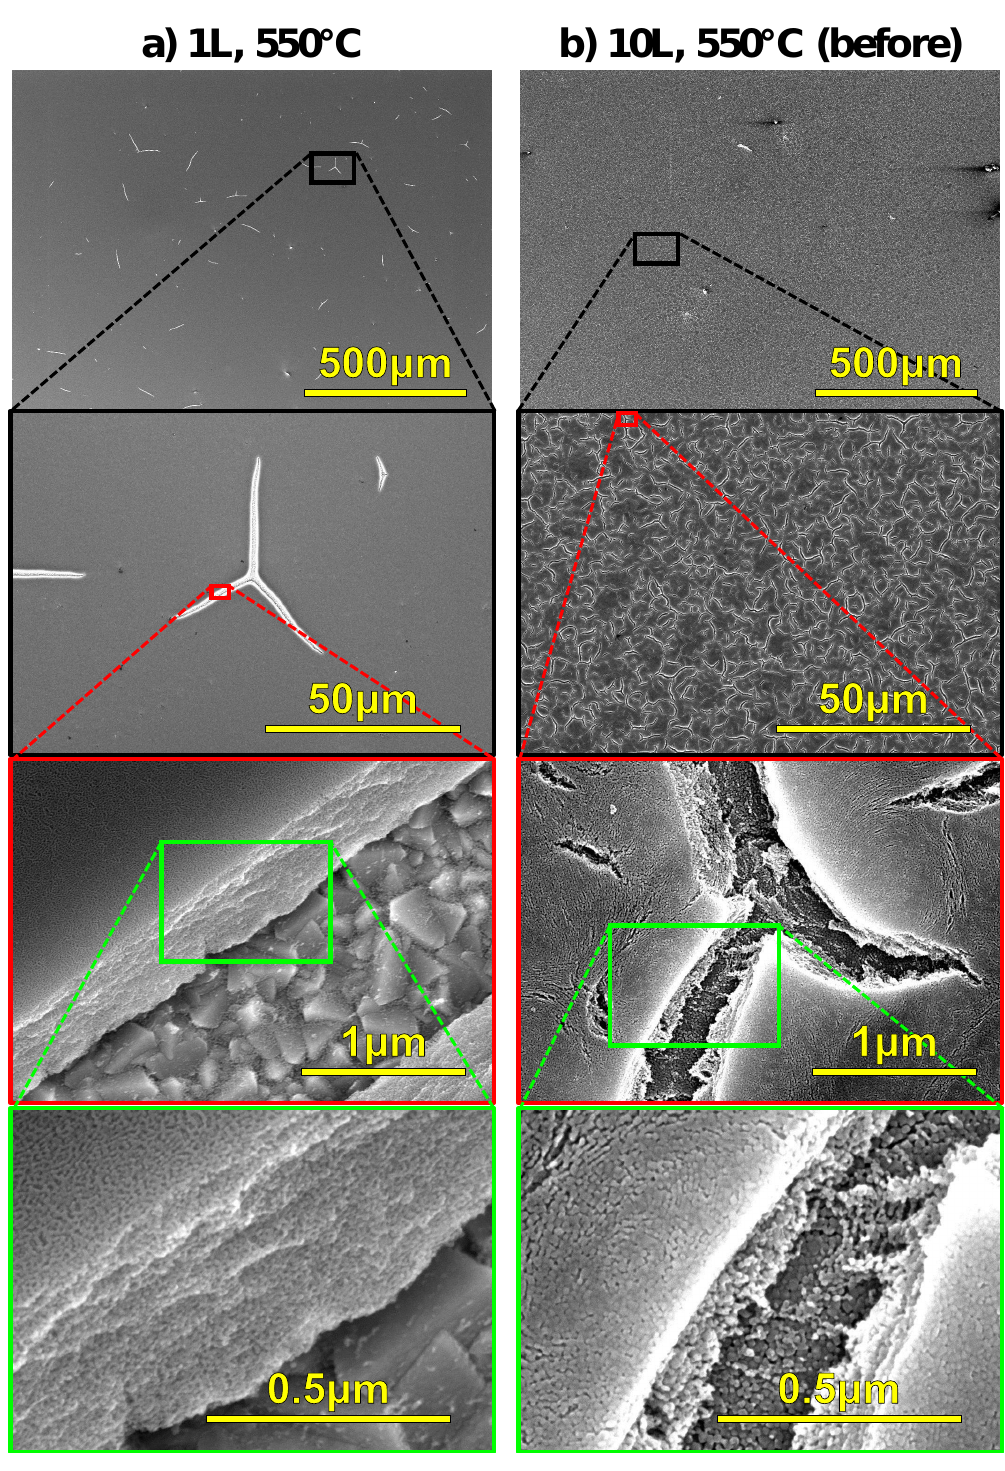
Figure 11. SEM top-view image of ( a ) single- and ( b ) ten-layered MTTFs at different magnifications showing that an extended network of microscopic cracks is formed in case of the multi-layered